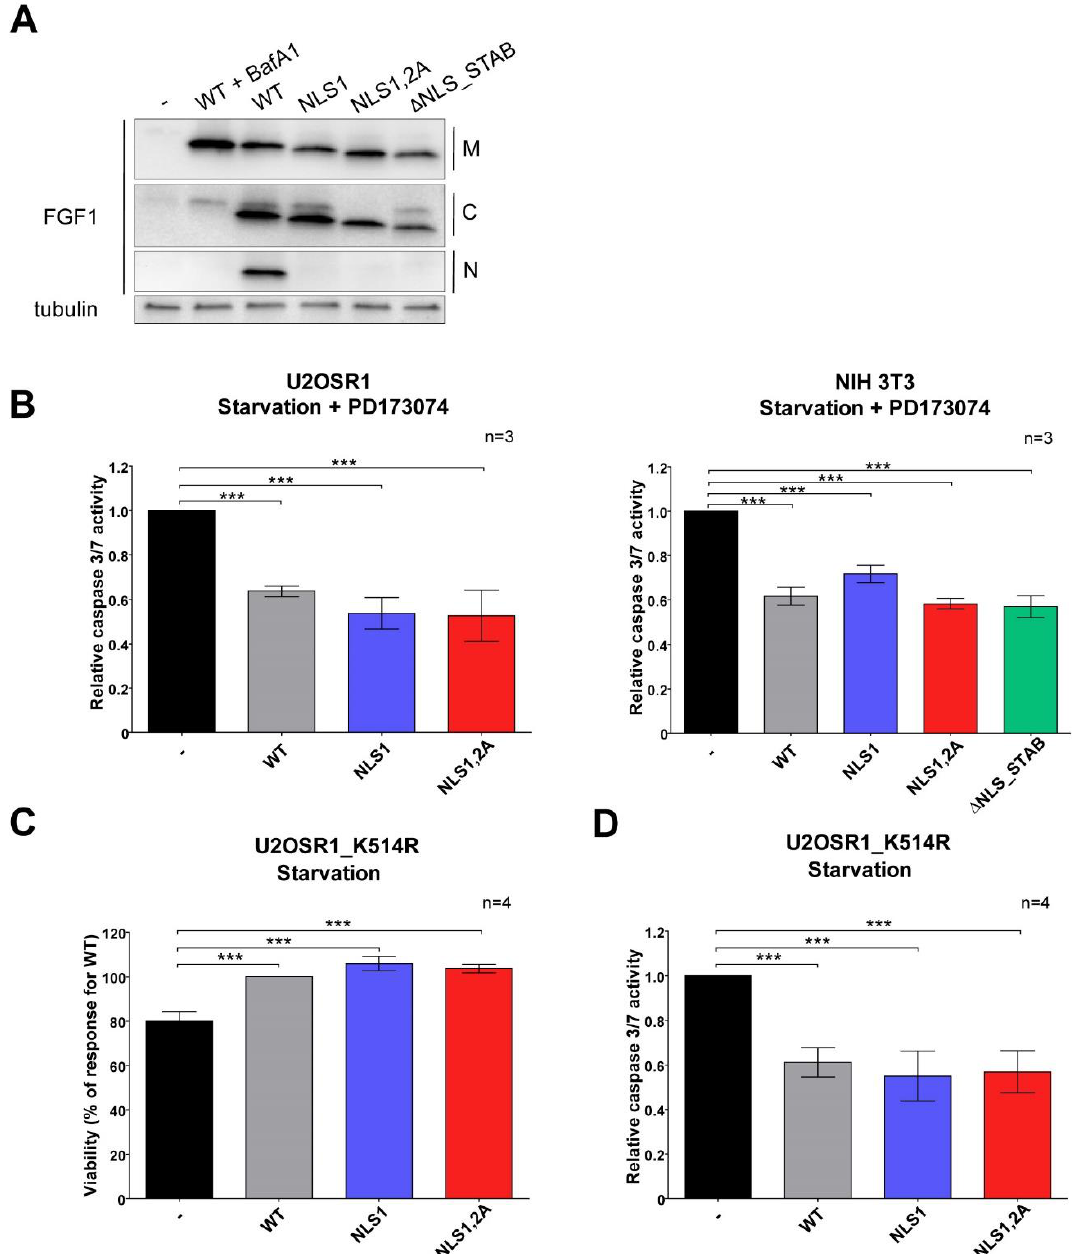
Figure 2. Translocated FGF1 inhibits apoptosis independently of its nuclear localization and receptor activation. ( A ) NLS variants are effectively translocated to cytosol but are defective in transport to the nucleus. The presence of FGF1 variants in the membrane (M), cytosolic (C) and nuclear (N) fractions was confirmed by subcellular fractionation after 6 h serum deprivation in U2OSR1 cells. Tubulin in the cytosolic fraction served as an equal loading control. ( B ) Anti-apoptotic activity of FGF1 variants at 100 ng/mL in serum-starved cells expressing FGFR1 (U2OSR1 and NIH 3T3) in the presence of potent chemical FGFR inhibitor (100 nM of PD17307), as determined by caspase 3/7 activity measured 16 h and 6 h after growth factors’ stimulation, respectively. ( C , D ) Anti-apoptotic activity of FGF1 variants at 100 ng/mL in serum-starved U2OSR1_K514R cells (U2OS cells stably expressing FGFR1 kinase-dead mutant), as determined by cell viability with Presto Blue reagent ( C ) and relative caspase 3/7 activity using ApoLive-Glo Multiplex Assay ( D ) evaluated 48 h and 16 h after growth factors’ stimulation, respectively. Data were normalized to control values and presented as means ± SD of three or four independent experiments. Statistical significance: *** p ≤